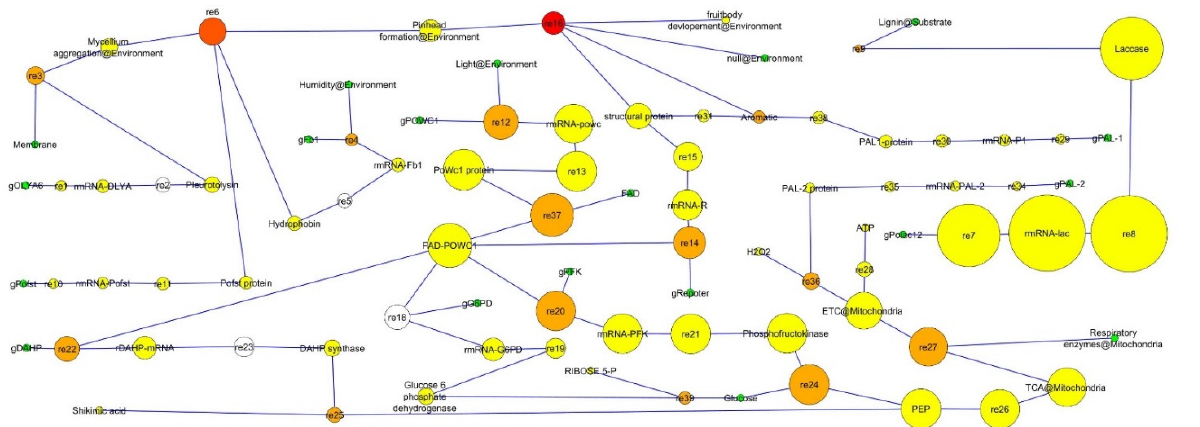
Figure 6. Mapping of the fruiting mechanism pathway: visualization of complete network pathway to map hub nodes.